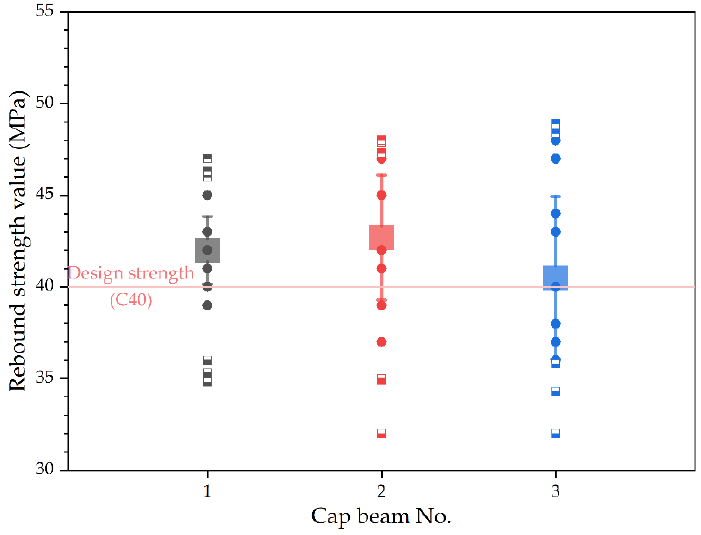
Figure 8. The rebound values of prefabricated cap beams after curing for 30 days.